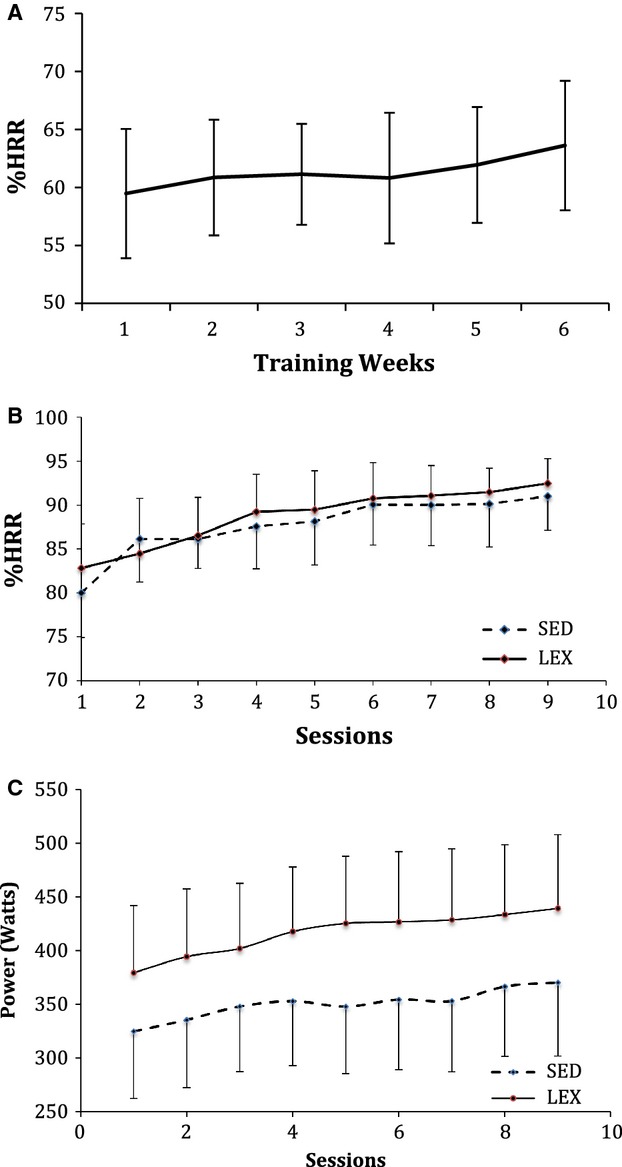
(A) Graph showing group mean weekly percentage heart rate reserve (%HRR) responses for
lifelong sedentary men (SED) during exercise training in Training Block 1. (B) Depicts group mean
%HRR for SED and a lifelong exercisers (LEX) during each of nine high intensity interval
training (HIIT) sessions. Data are presented as mean ± SD. (C) Depicts group mean power
output (MPO) for SED LEX during each of nine HIIT sessions. Data are presented as mean ±
SD.